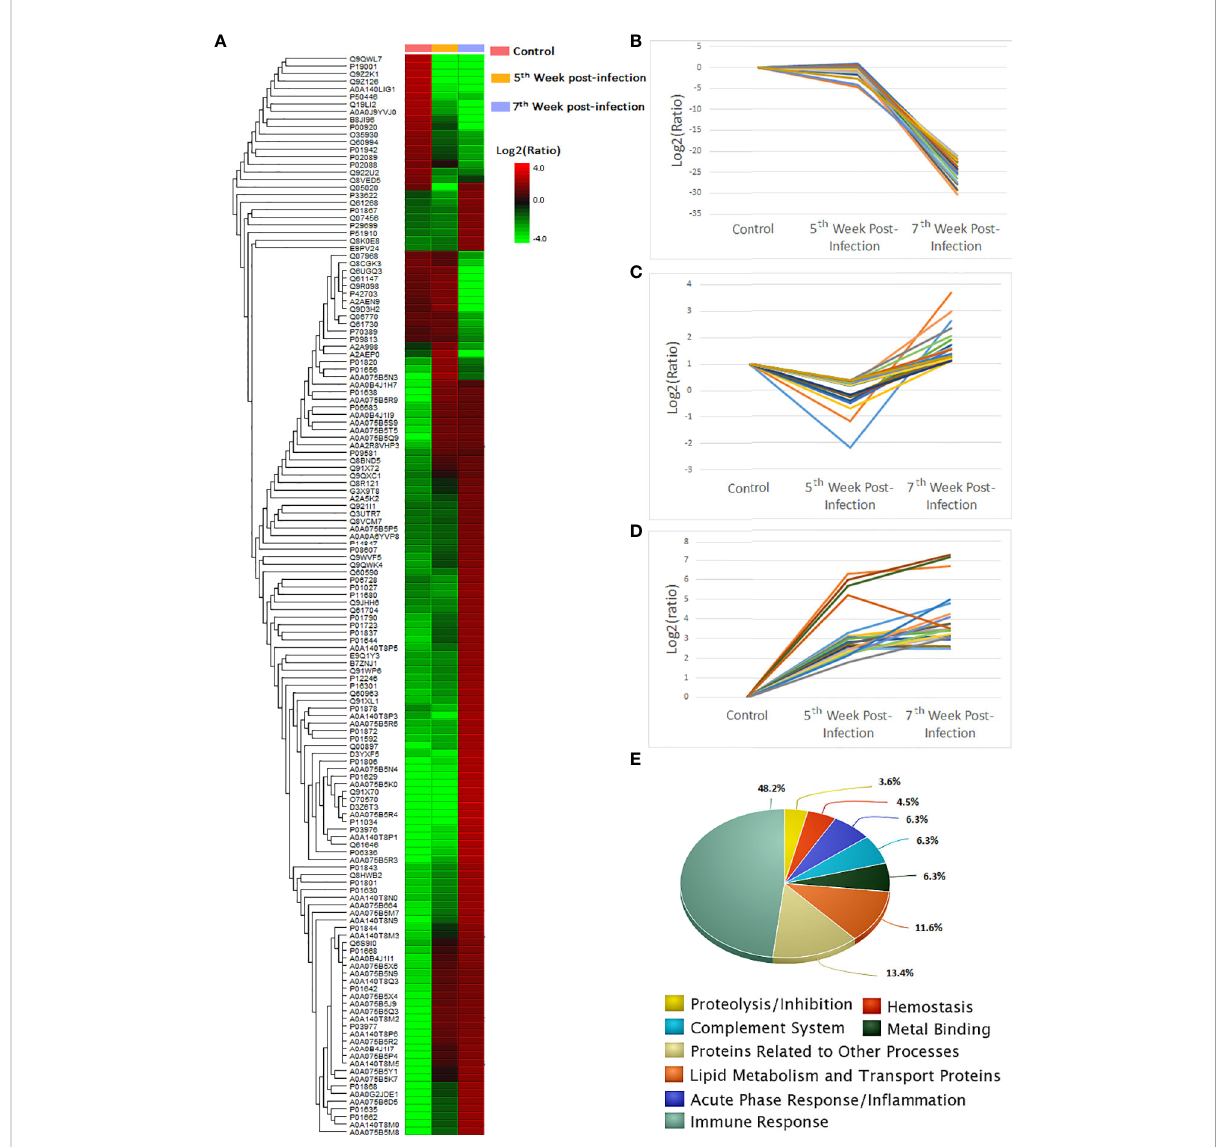
FIGURE 2 Heatmap of differentially abundant serum proteins in the context of S. mansoni infection in the murine model. (A) A total of 143 molecules with fold changes ≥ 2 were listed. Lipid transport and metabolism related proteins are marked in red. (B-D) Distinct expression patterns for differentially abundant serum constituents during S. mansoni infection. Molecules displaying downregulation in infected samples (B) ; downregulation at week 5 post-infection followed by upregulation at week 7 (C) ; upregulation in both time points (D) ; list of theses molecule identities is seen on Supplementary Table 3. (E) Functional categorisation according to biological processes for differentially abundant serum